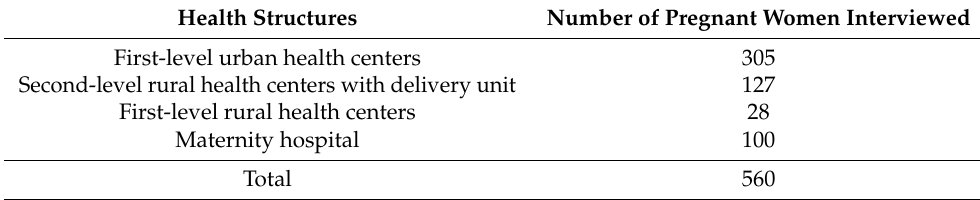
Table 1. Distribution of pregnant women interviewed by health structures.